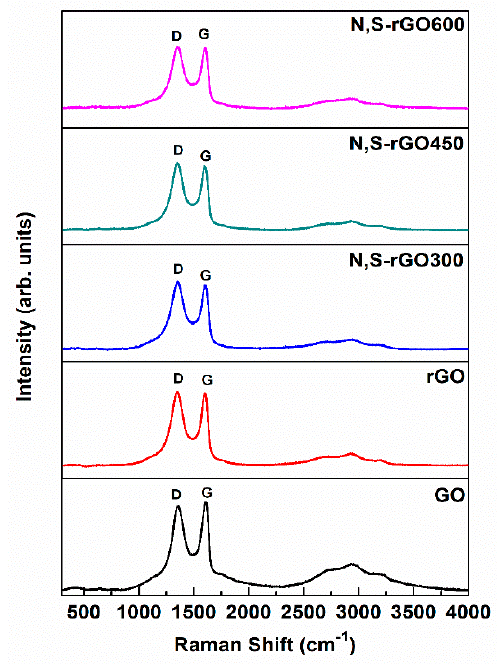
Figure 2. XRD patterns for precursors of coatings.